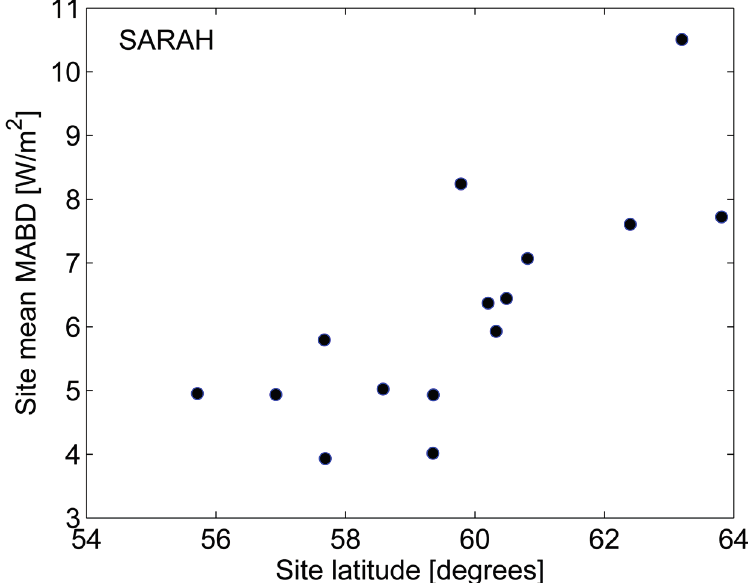
Figure 6. Site mean Mean Absolute Bias Difference (MABD) as a function of site latitude for